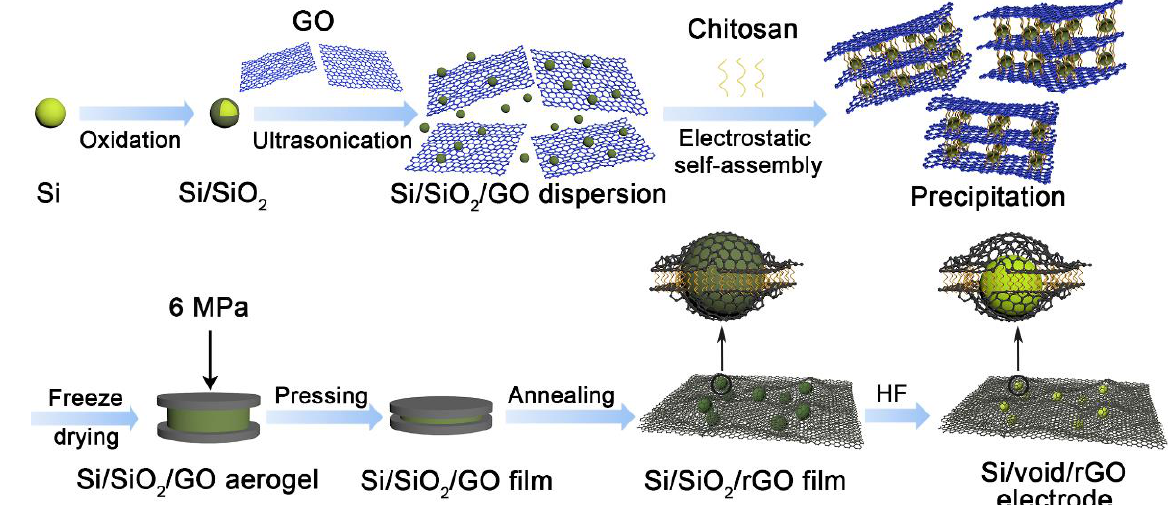
Figure 1. Schematic illustration of the fabrication process of free-standing Si/void/rGO electrode.